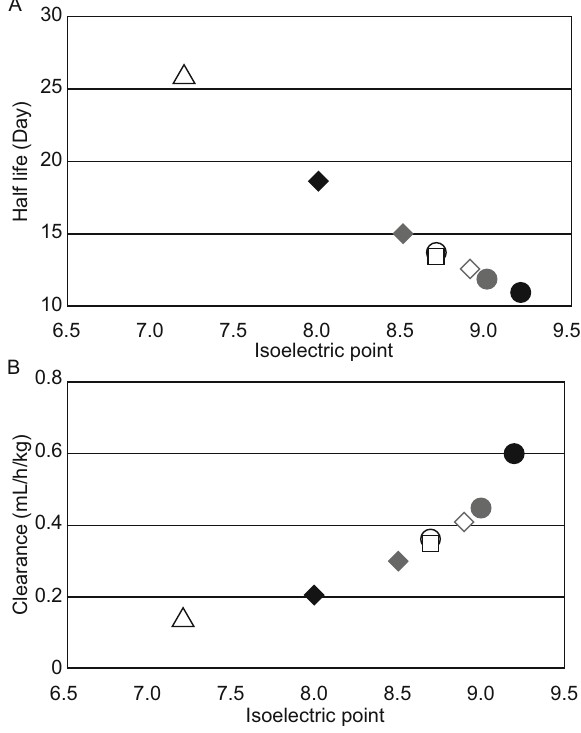
Figure 3. Relationship between charge/pI and half-life and clearance in PK of mAbs. Reproduced from Igawa et al., with permission